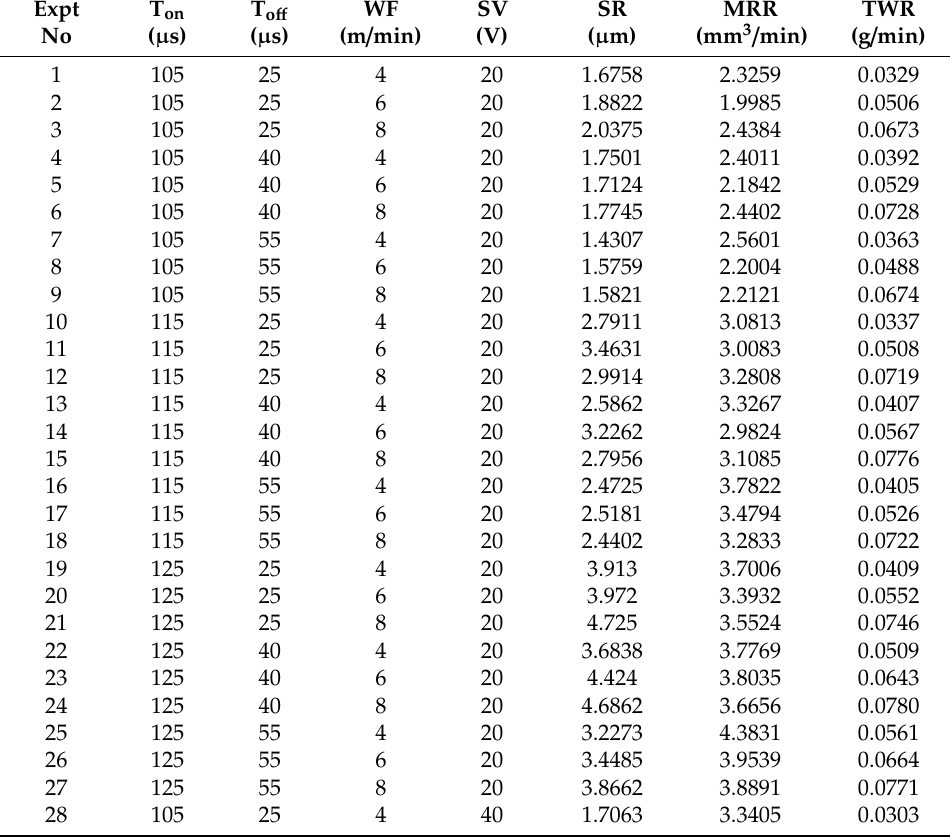
Table 2. Experimental plan and related